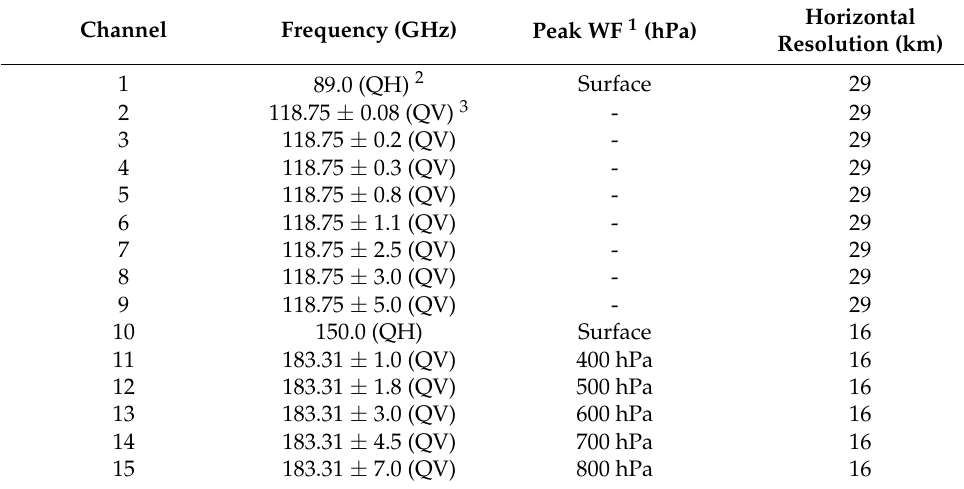
Table 1. Channel frequency and the peaks of weight function (WF) for MWHS-2.